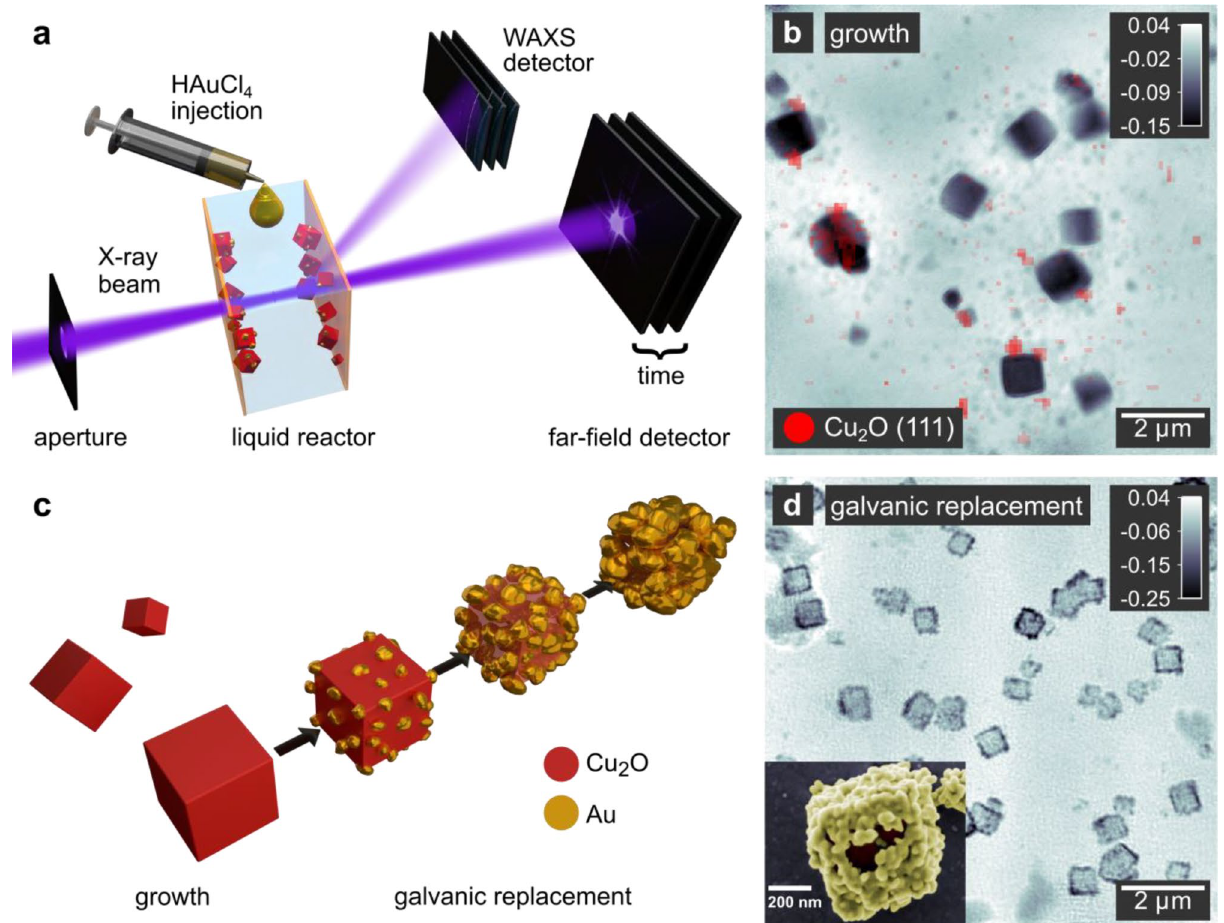
Figure 1. Outline of the multimodal in situ imaging experiment on Cu 2 O@Au nanocages. ( a ) Schematic illustration of the experimental setup showing a section of the in situ reactor for simplicity. The nanocubes grow on the inner walls of the reactor. ( b ) Ptychographic reconstruction of Cu 2 O nanocubes growing inside the chemical reactor. The image is overlaid with the spatially resolved diffraction signal (in red), representing diffraction from the Cu 2 O (111) crystallographic plane. ( c ) Illustration of the observed reaction pathway including the growth of Cu 2 O nanocubes and their morphological transformation into gold nanocages during SEM image of a partly replaced